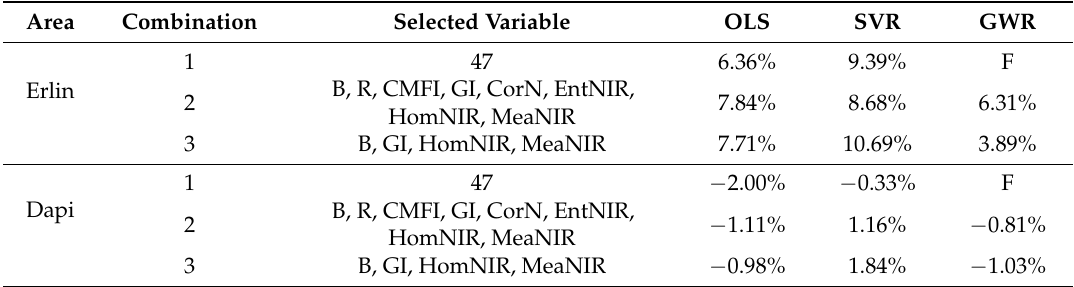
Table 7. Rice yield estimation for 2017 in the first cultivations with mixed ground survey data from Erlin and Dapi in 2016 and